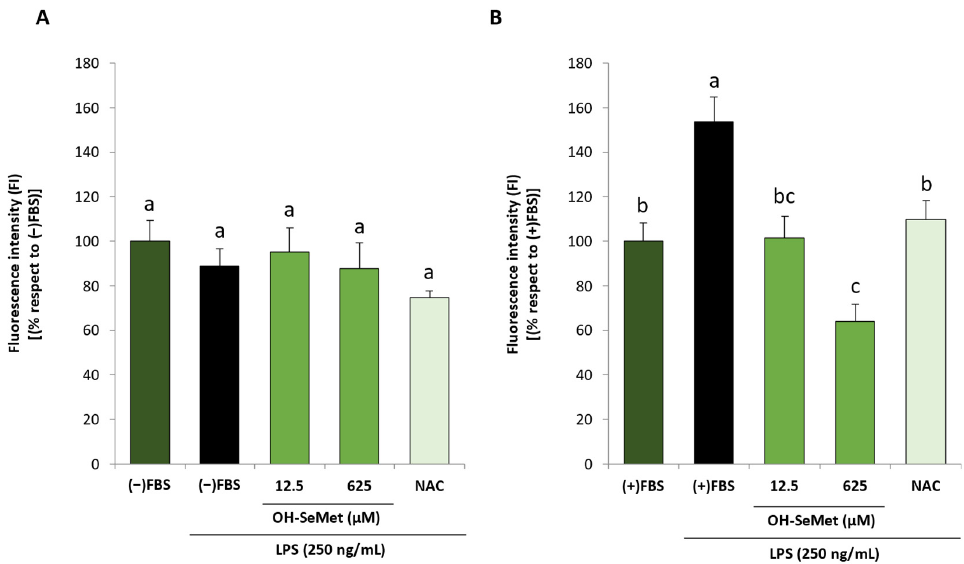
Figure 7. Autofluorescence in macrophages maintained in ( − )FBS or (+)FBS for 24 h ( A , B , respec- tively), supplemented for 24 h with 12.5 and 625 μ M OH-SeMet or 10 mM NAC and then stimulated with LPS (250 ng/mL) for 24 h. The results are expressed as mean ± SEM of n = 12 macrophages. Different letters denote significant differences ( p < 0.05) between conditions for each LPS concentration. Table 1. Cytokine production (TNF α , IL-1 β and IL-10) in macrophages maintained in ( − )FBS or (+)FBS for 24 h and then stimulated with LPS (100 and 250 ng/mL) for 4 or 24 h. The results are expressed as mean ± SEM of n = 9 cultures. The asterisk (*) denotes significant differences ( p < 0.05) between ( − )FBS and (+)FBS. ND, not detected.